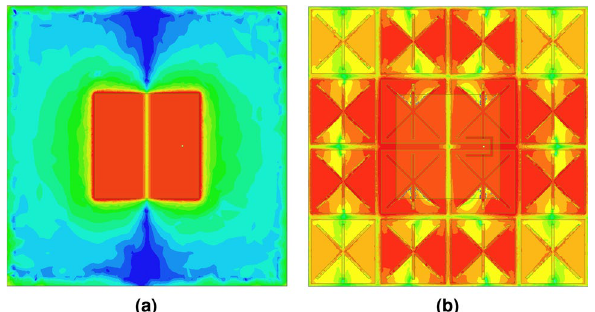
Figure 10. E-field distributions under the FR4 layer on the x – y plane for 1 W input power at 868 MHz for the ( a ) typical patch antenna; ( b ) MPA structure. Scale: logarithmic with 15 subdivisions ranging from 1 to 2 10 3 V/m. ×